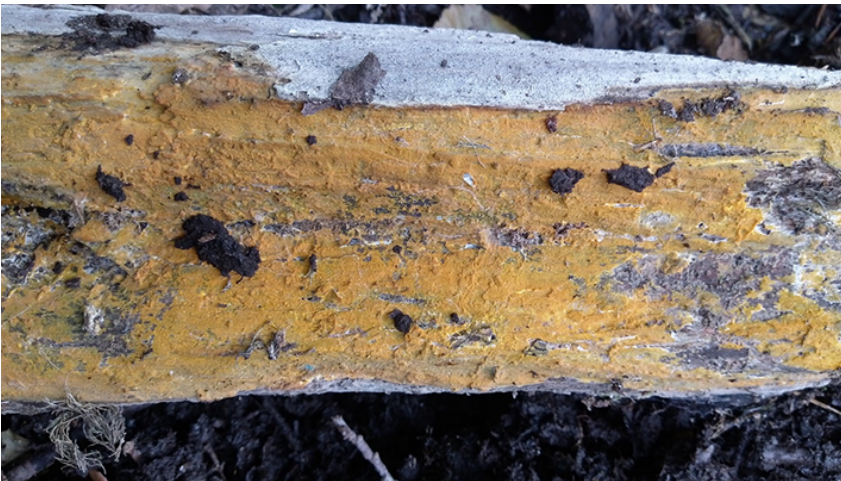
Figure 11 Old basidiomata of Phlebia subochracea (Bres.) J. Erikss. & Ryvarden. Photography by Anna